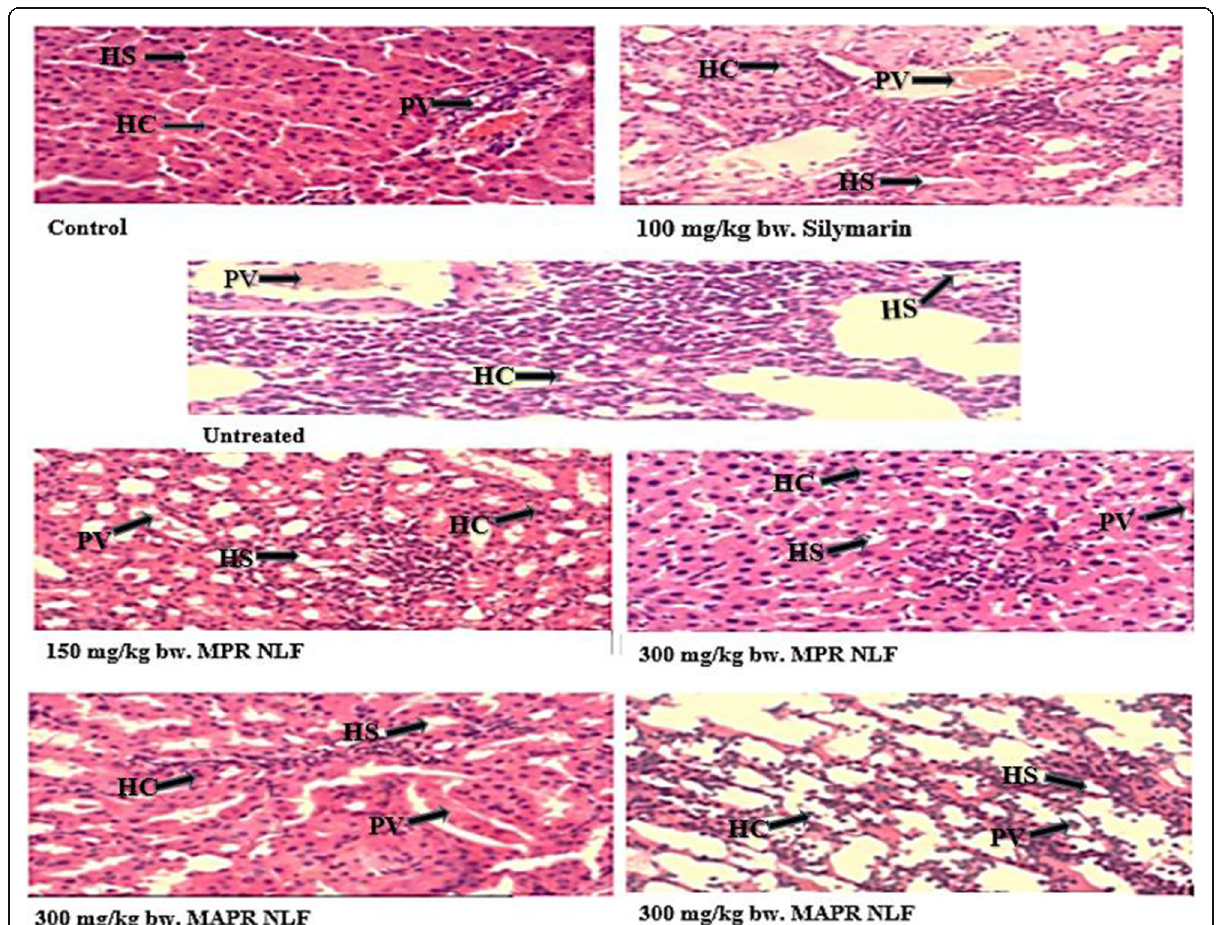
Fig. 1 Histology of the Liver of male Wistar rats administered with lead acetate and treated with methanol and methanol/ acetone phenolic-rich extract of N. latifolia fruit (mg × 40). HS; Hepatic sinusoids, PV; Portal vein; HC;